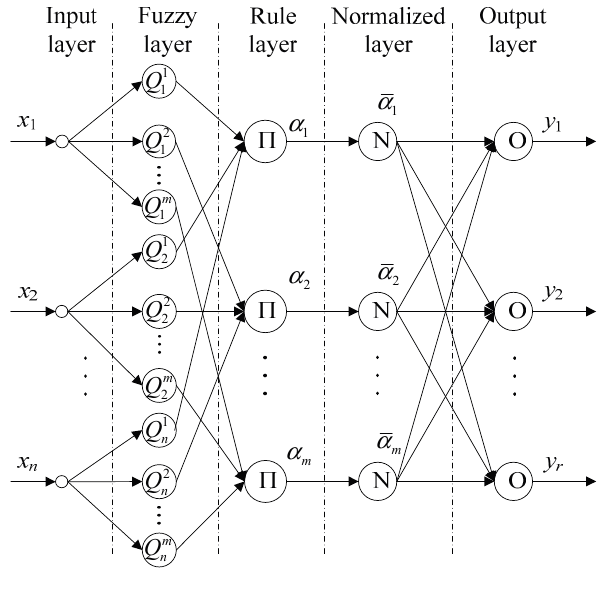
Figure 2. Structure of